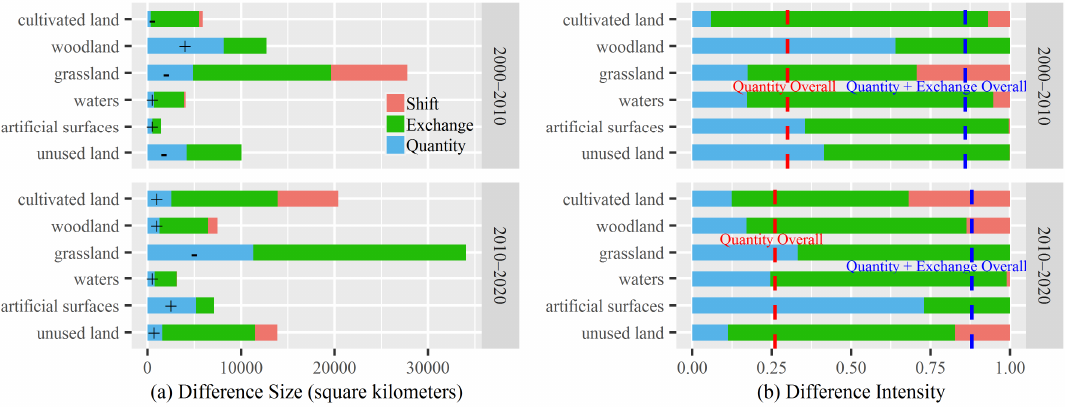
Figure 10. Size ( a ) and Intensity ( b ) of differences for upper reaches of the YRB. The sign “+” denotes net gain and the sign “−” denotes net loss.